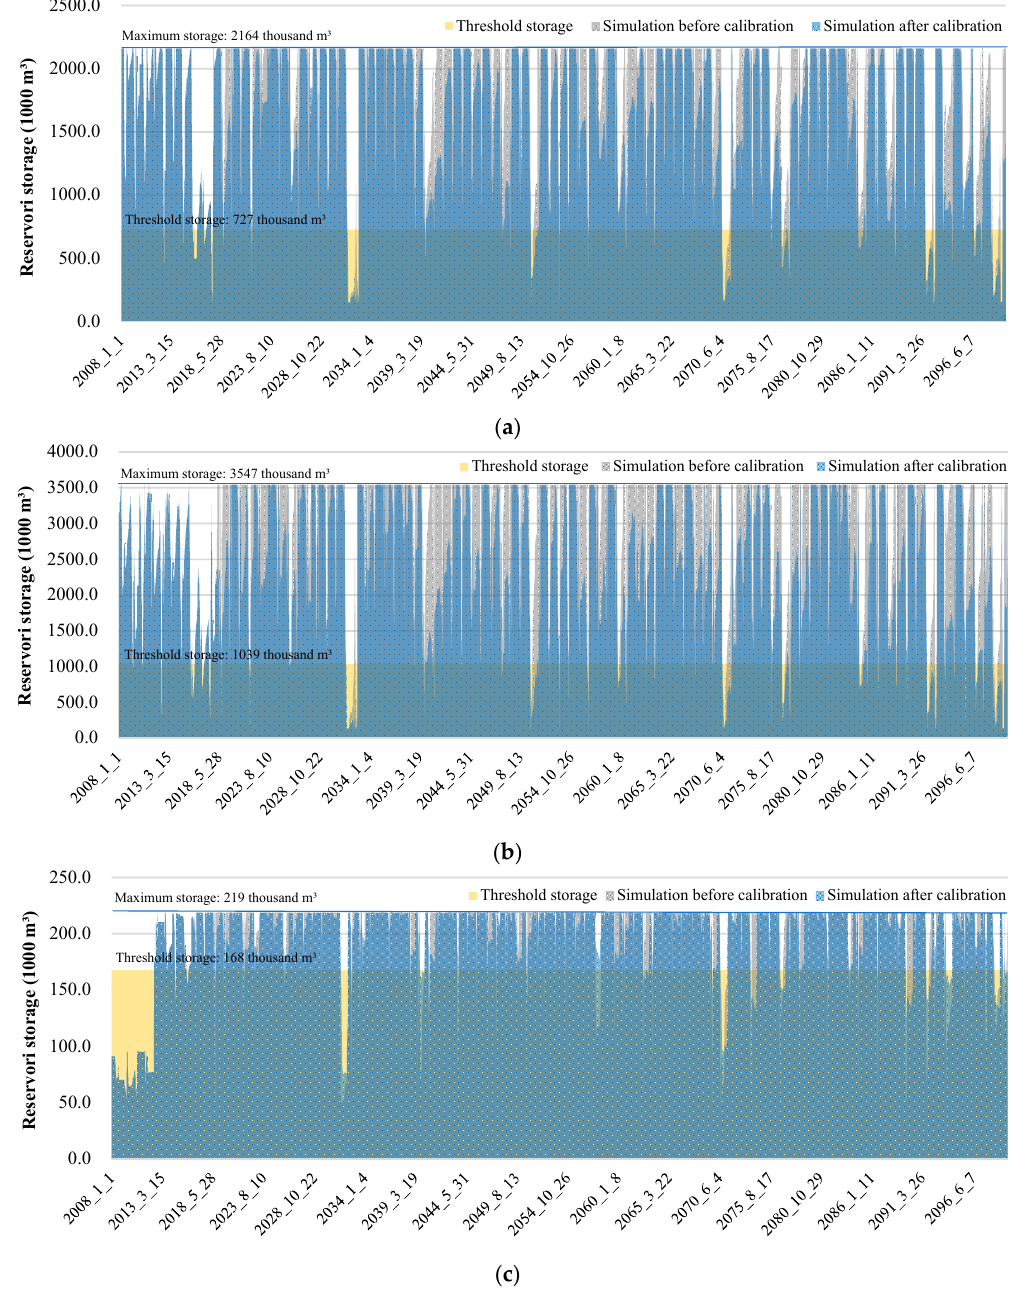
Figure 8. Simulation of reservoir water storage in Kicheon, Deokwoo, and Samchun reservoirs from 2008 to 2099 before and after calibration. ( a ) Kicheon reservoir; ( b ) Deokwoo reservoir; ( c ) Samchun reservoir.